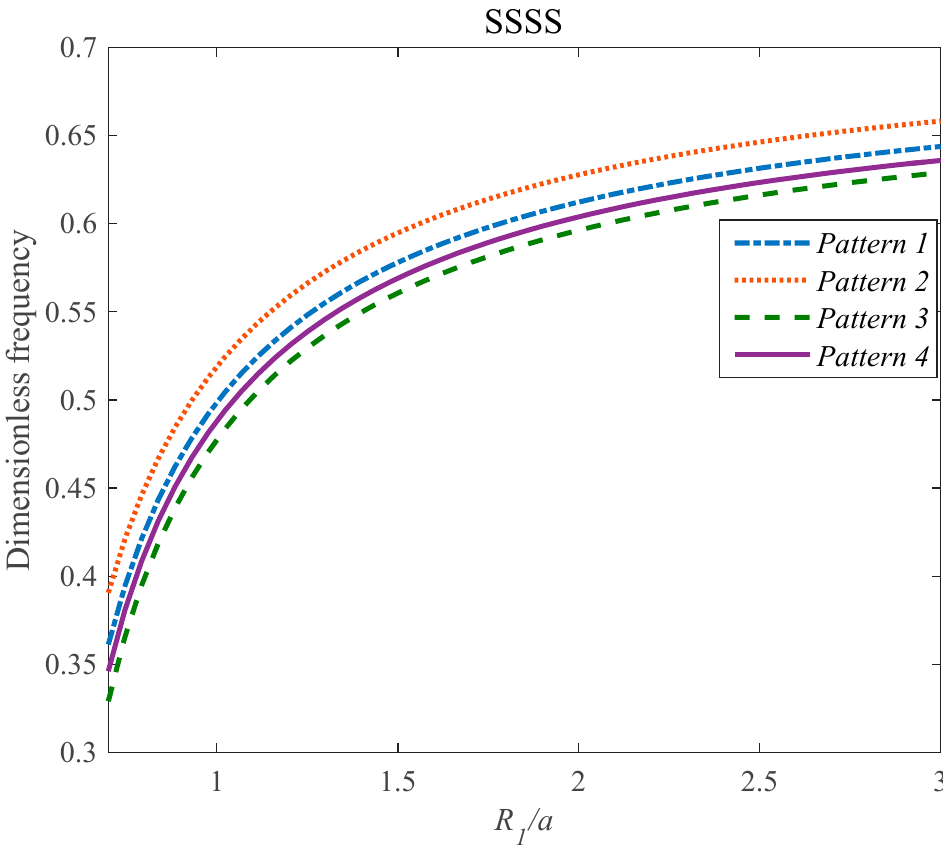
Figure 7. The e ff ects of R 1 / a and GPLRC’s pattern on the frequency for the SSSS boundary conditions Figure 7. The effects of R 1 /a and GPLRC’s pattern on the frequency for the SSSS boundary conditions (a / b = 5, h = b / 10, R 2 = 5a, ∆ T = 100 K , g GPL = 0.5%, N L = 10, µ = h /10, l = h (a/b = 5, h = b/10, R2 = 5a, ∆𝑇 (cid:3404) 100𝐾, 𝑔 (cid:3008)(cid:3017)(cid:3013) = 0.5%, N L = 10, 𝜇 (cid:3404) ℎ/10,𝑙 (cid:3404) ℎ/5 ).